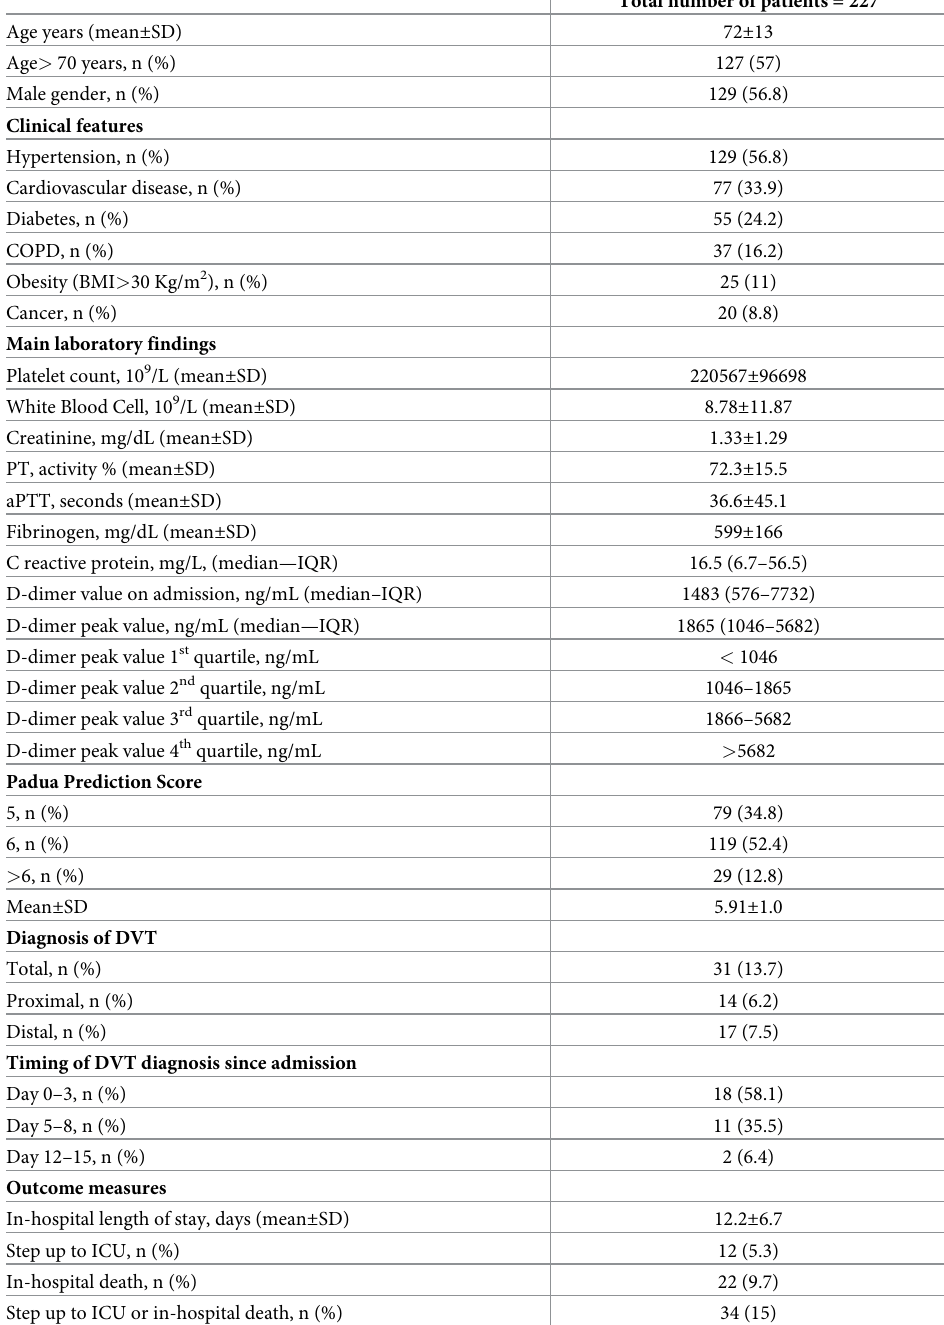
Table 1. Demographic, clinical characteristics and laboratory findings and outcomes of the entire cohort of